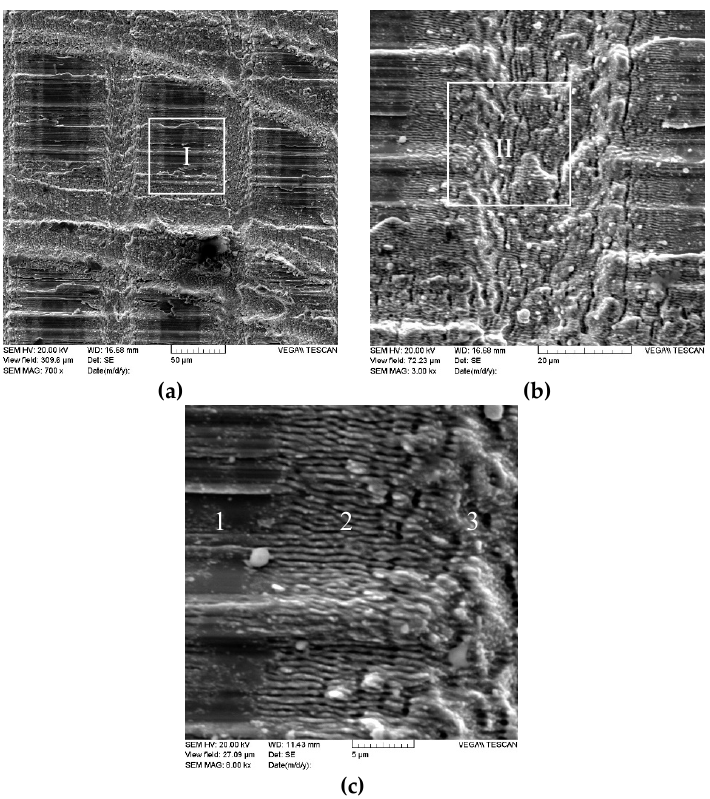
Figure 3. SEM images: ( a ) regularly arranged micro-grooved textures containing self-organized hierarchical structures micro/LIPSS; ( b ) enlargement of the marked area I. ( c ) Enlargement of the marked area II: 1—initial grinded surface; 2—nano LIPSS; 3—groove with self-organized hierarchical micro/LIPSS structures.